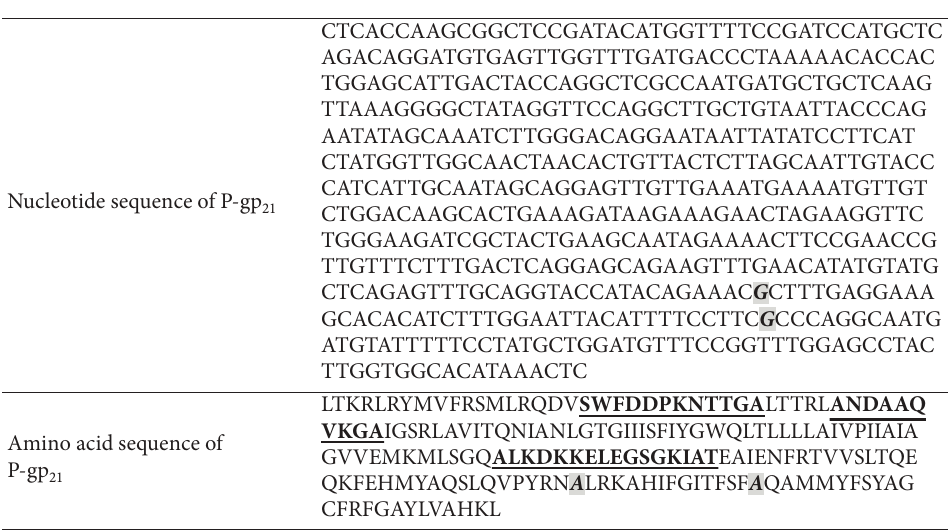
Table 1: BLAST of the P-gp